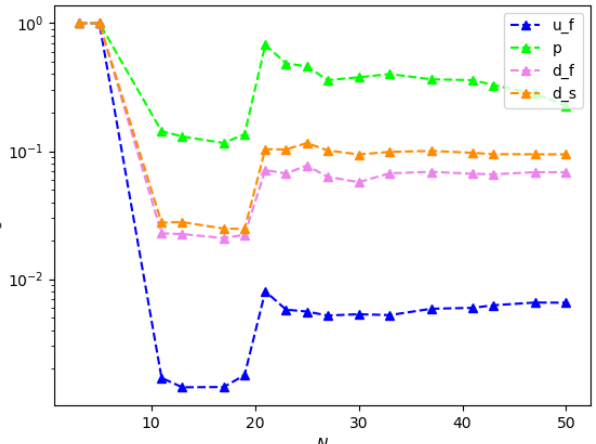
Figure 12. Average relative error as a function of the number of basis functions used in the online system.